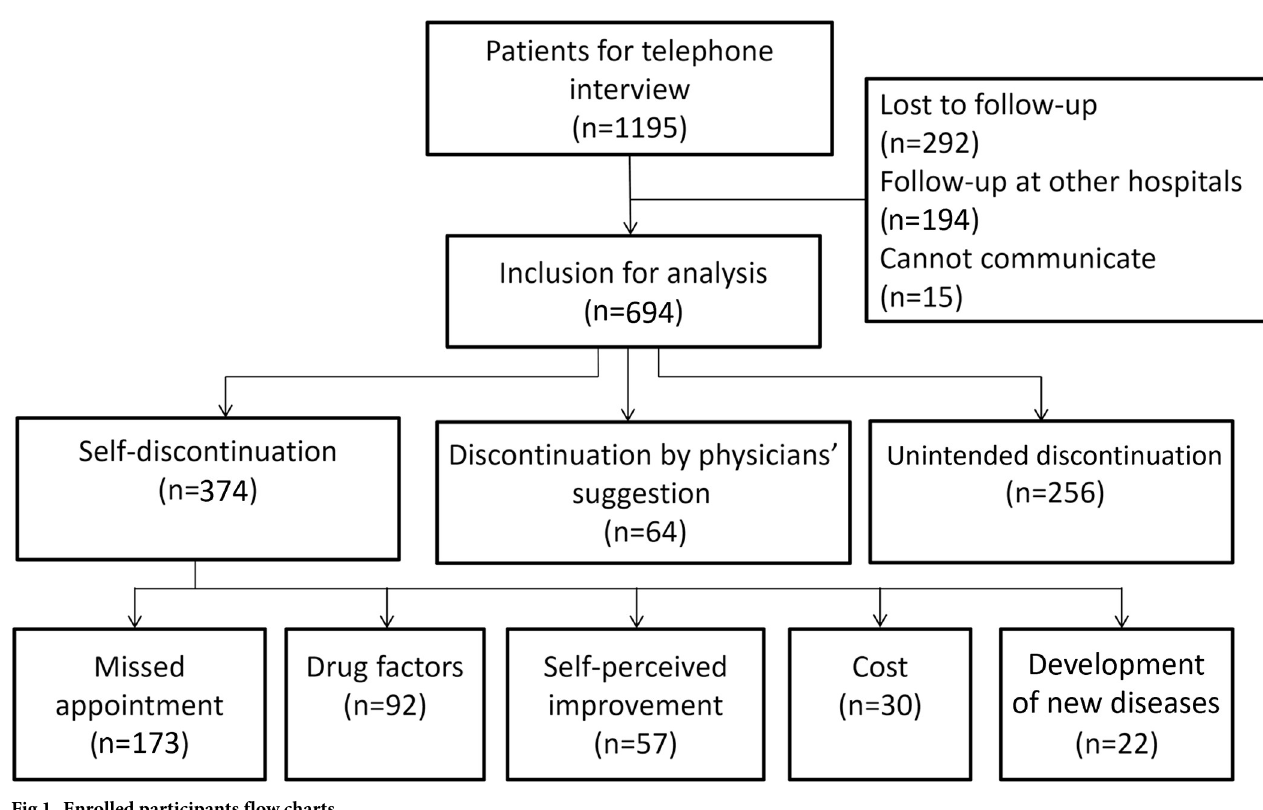
Fig 1. Enrolled participants flow